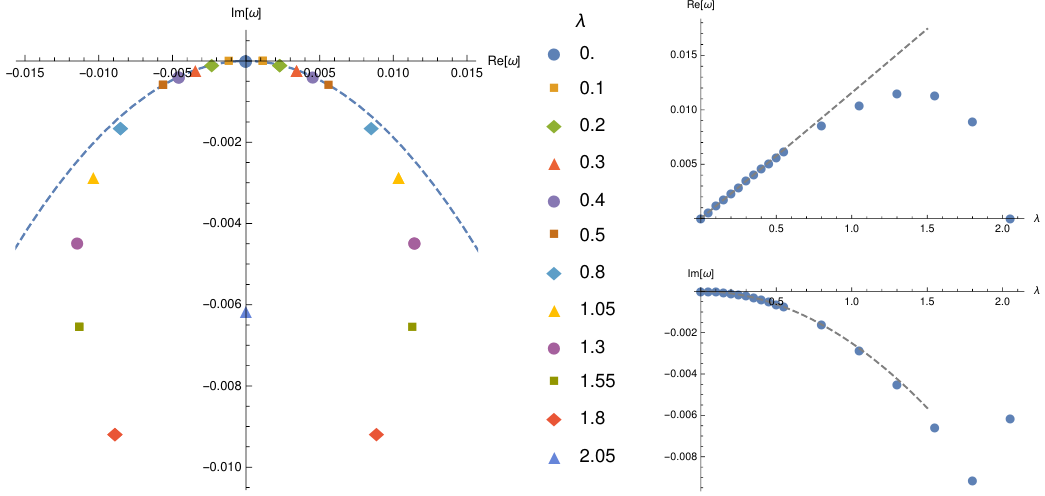
Figure 4 . QNMs at zero momentum in the spontaneously broken phase ( T = 0 : 52 T c )with increas- ing amplitude of explicit symmetry breaking (cid:21) . The rising pinning frequency of the phonon is seen (right panel) as a function of (cid:21) . Left panel: trajectories of QNMs in the complex plane, Right panel: dependence of the real and imaginary parts on (cid:21)